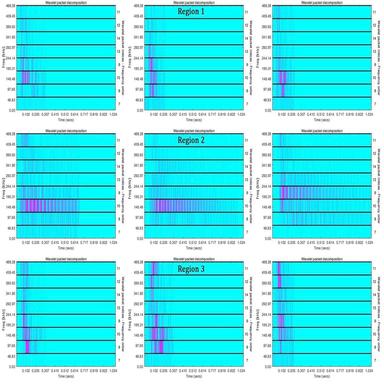
WPT analysis of AE hits in specimen A